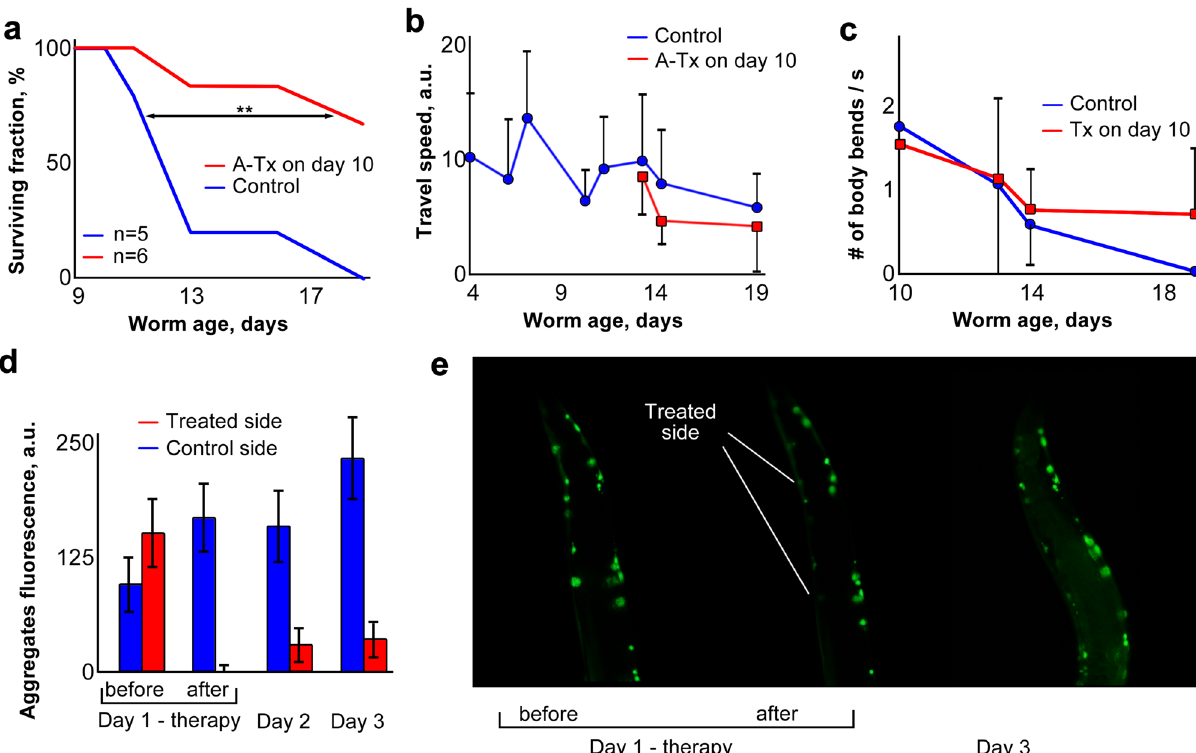
Figure 4. Asymmetric laser therapy in nematodes. ( a ) Lifespan survivals (**Cox–Mantel log-rank p < 0.013). ( b , c ) Video analysis of motility (travel speed; body-flexion frequency); differences were not significant. ( d ) Aggregate fluorescence intensity on treated vs. control sides. Treated side differed from control side at days 2 and 3, each p < 0.015 by paired t test; combined p < 1E–9. ( e ) Fluorescence imaging of laser-treated nematodes before, immediately after, and 48 h after laser treatment. Error bars in ( b – d ) indicate standard deviations; some are omitted for clarity in ( c